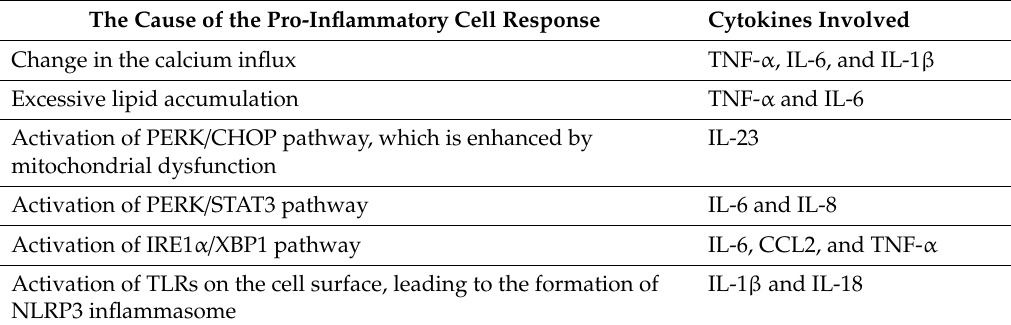
Table 3. Macrophage pro-inflammatory response during endoplasmic reticulum